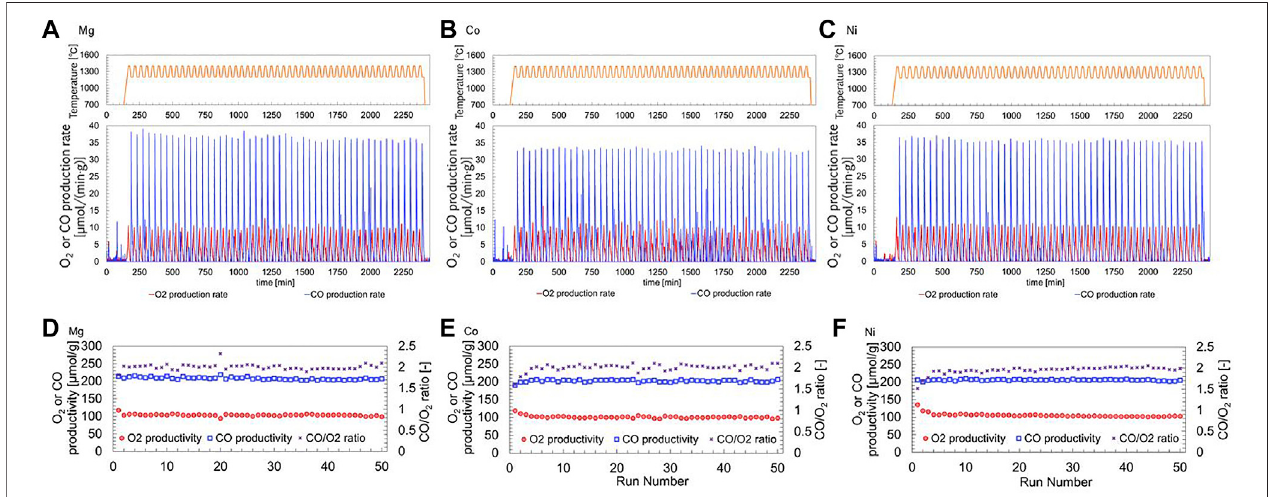
FIGURE 7 | Thermal durability and stability of redox materials for long-term thermochemical cycling. Temperature, O 2 and CO production pro fi les of (A) Mg-, (B) Co, (C) Ni-substituted LSMs, and O 2 and CO productivities and CO/O 2 ratios of (D) Mg-, (E) Co, (F) Ni-substituted LSMs. The O 2 and CO productivities correspond to left Y-axis, while the O 2 /CO ratio of each production correspond to right